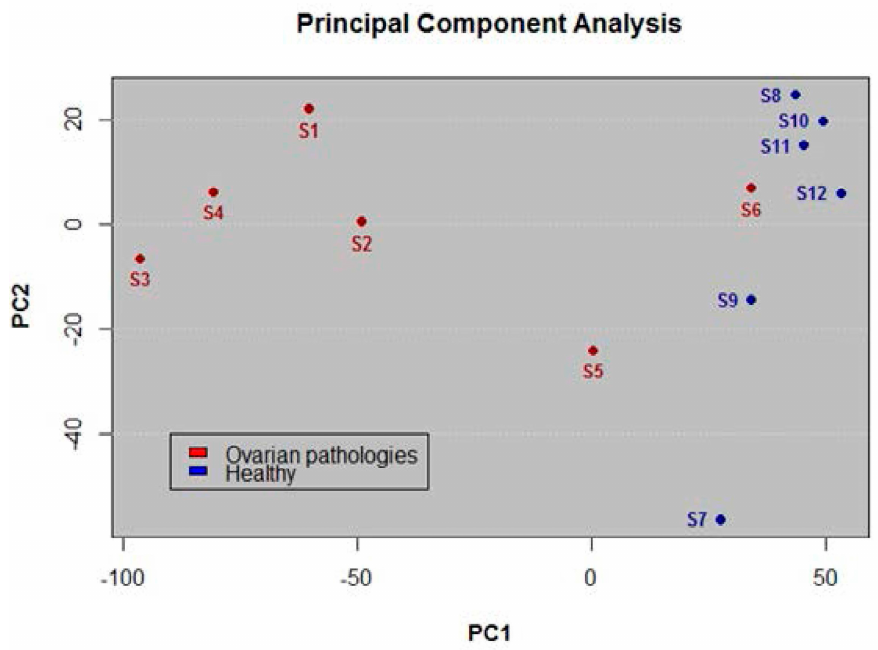
Figure 1. PCA of 1338 significant genes. Plot of the PC1 versus PC2. Clear differentiation is observed between the two study groups.